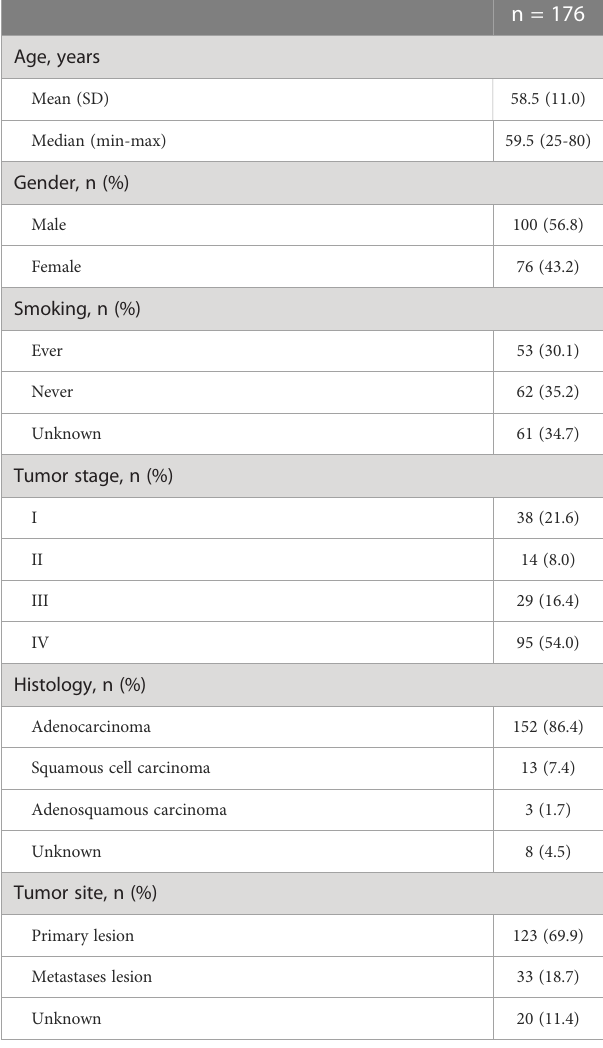
TABLE 1 Demographic and baseline characteristics of 176 treatment- naïve NSCLC patients with HER2